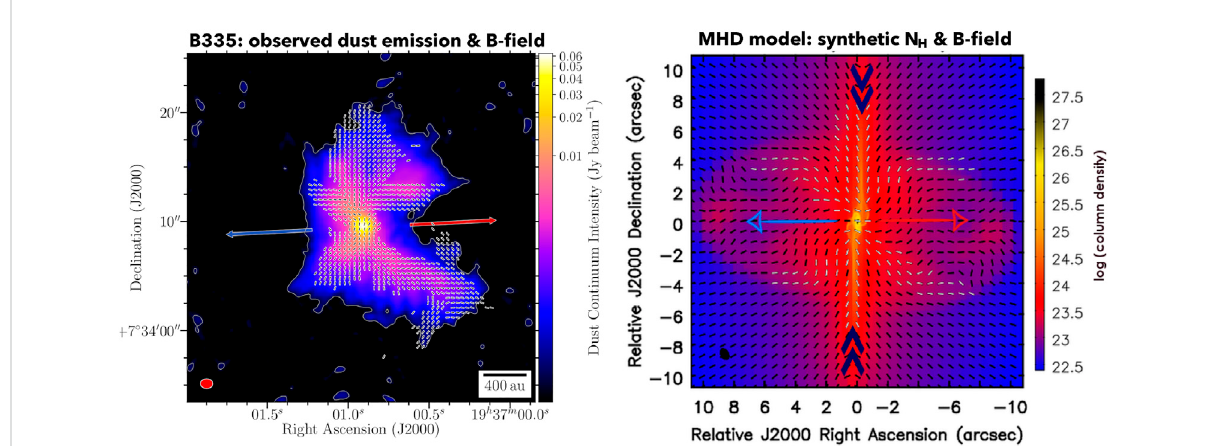
FIGURE 12 Observation and best model to match the properties in the B335 protostar, from Maury et al. (2018). The observed B fi eld geometry is shown in the left panel, the small disk size and the kinematics of the B335 inner envelope can only be explained by a family of MHD models where the initially poloidal fi eld in B335 is being pulled in the dominant direction of the collapse, but yet is strong enough ( μ ~ 6) to counteract partially the transfer of angular momentum inward and set the disk size in this Class 0 protostar: the best model is shown in the right